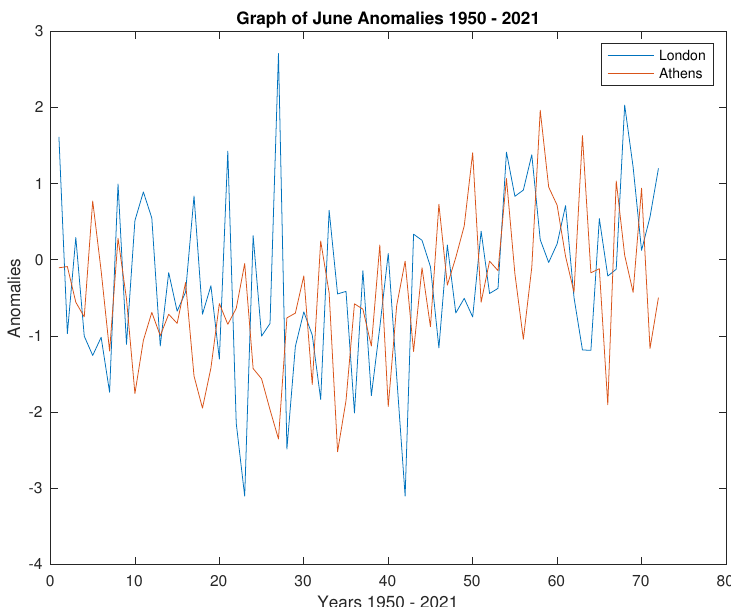
Figure 17. Graph of June Anomalies 1950–2021.